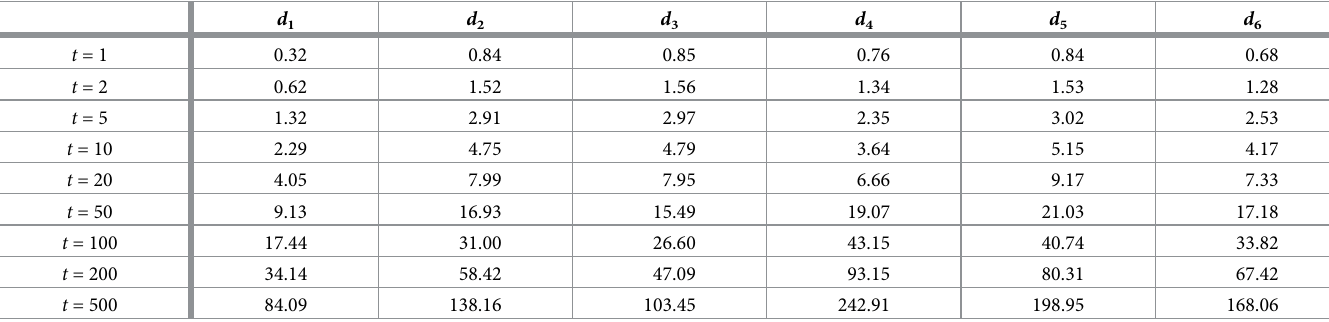
Table 1. The average queue size at time t for dropping functions d 1 − d 6